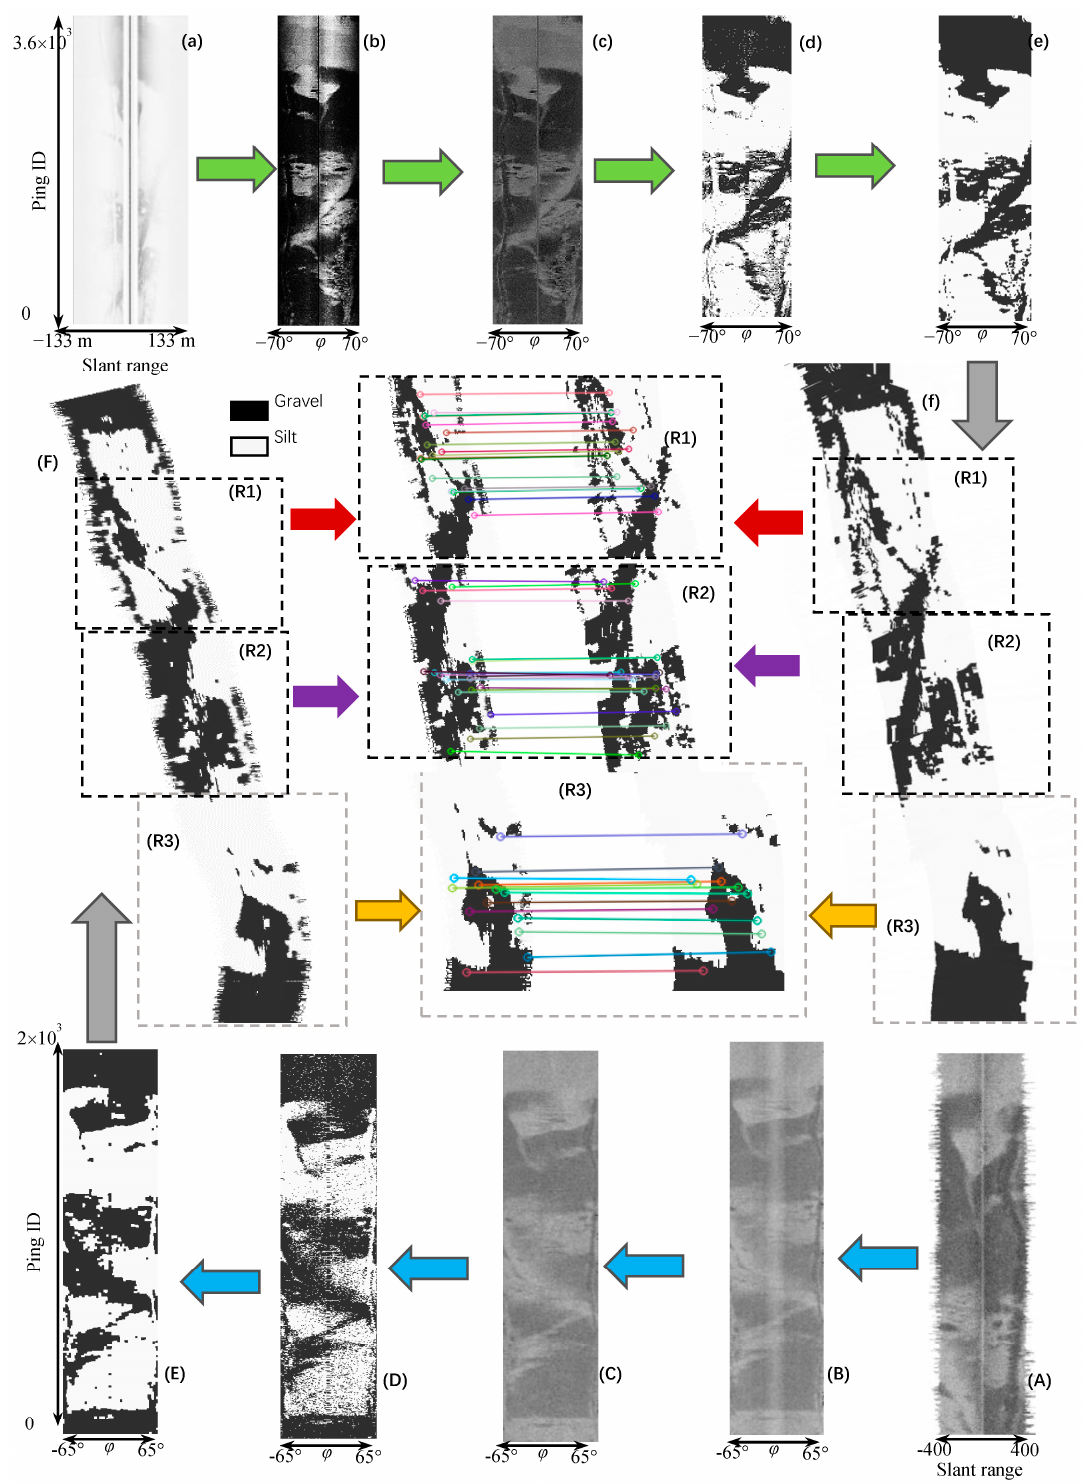
Figure 10. Segmental matching of MBES and SSS images. ( a ) SSS waterfall image; ( b ) transformed angular image from ( a ); ( c ) normalized image of ( b ); ( d ) SSS sediment image; ( e ) denoised image of ( d ); and ( f ) geocoded image of ( e ). ( A ) MBES snippet waterfall image, ( B ) transformed angular image from ( A ), ( C ) normalized image, ( D ) MBES sediment image, ( E ) denoised sediment image, and ( F ) geocoding image of ( E ). ( R1 – R3 ) three segments divided from the MBES image according to the distributions of seabed sediments and targets. φ is the incident angle.